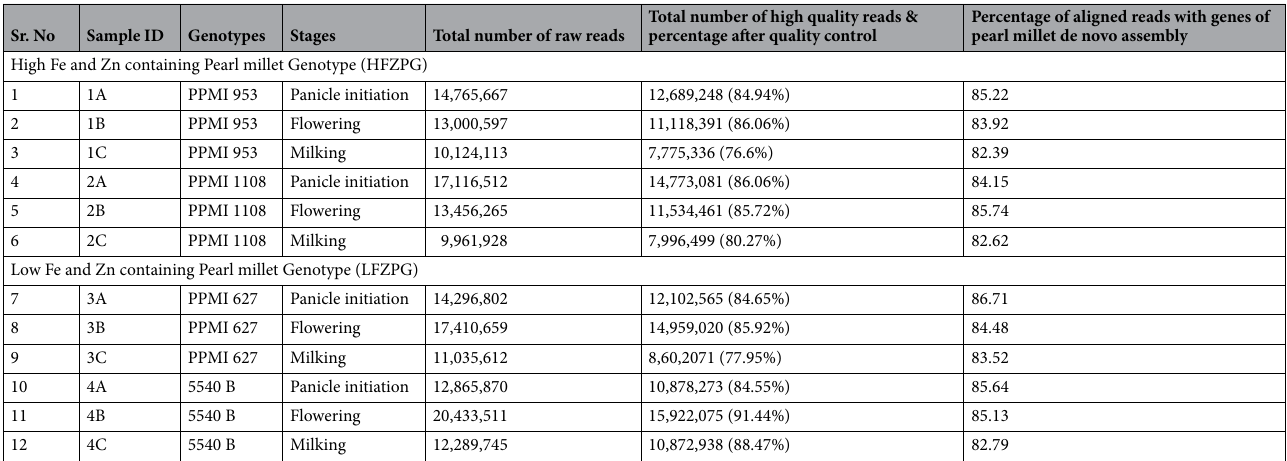
Table 2. Reads, de-novo assembly and mapping statistics of 2 high and 2 low-Fe & Zn containing genotypes of pearl millet.